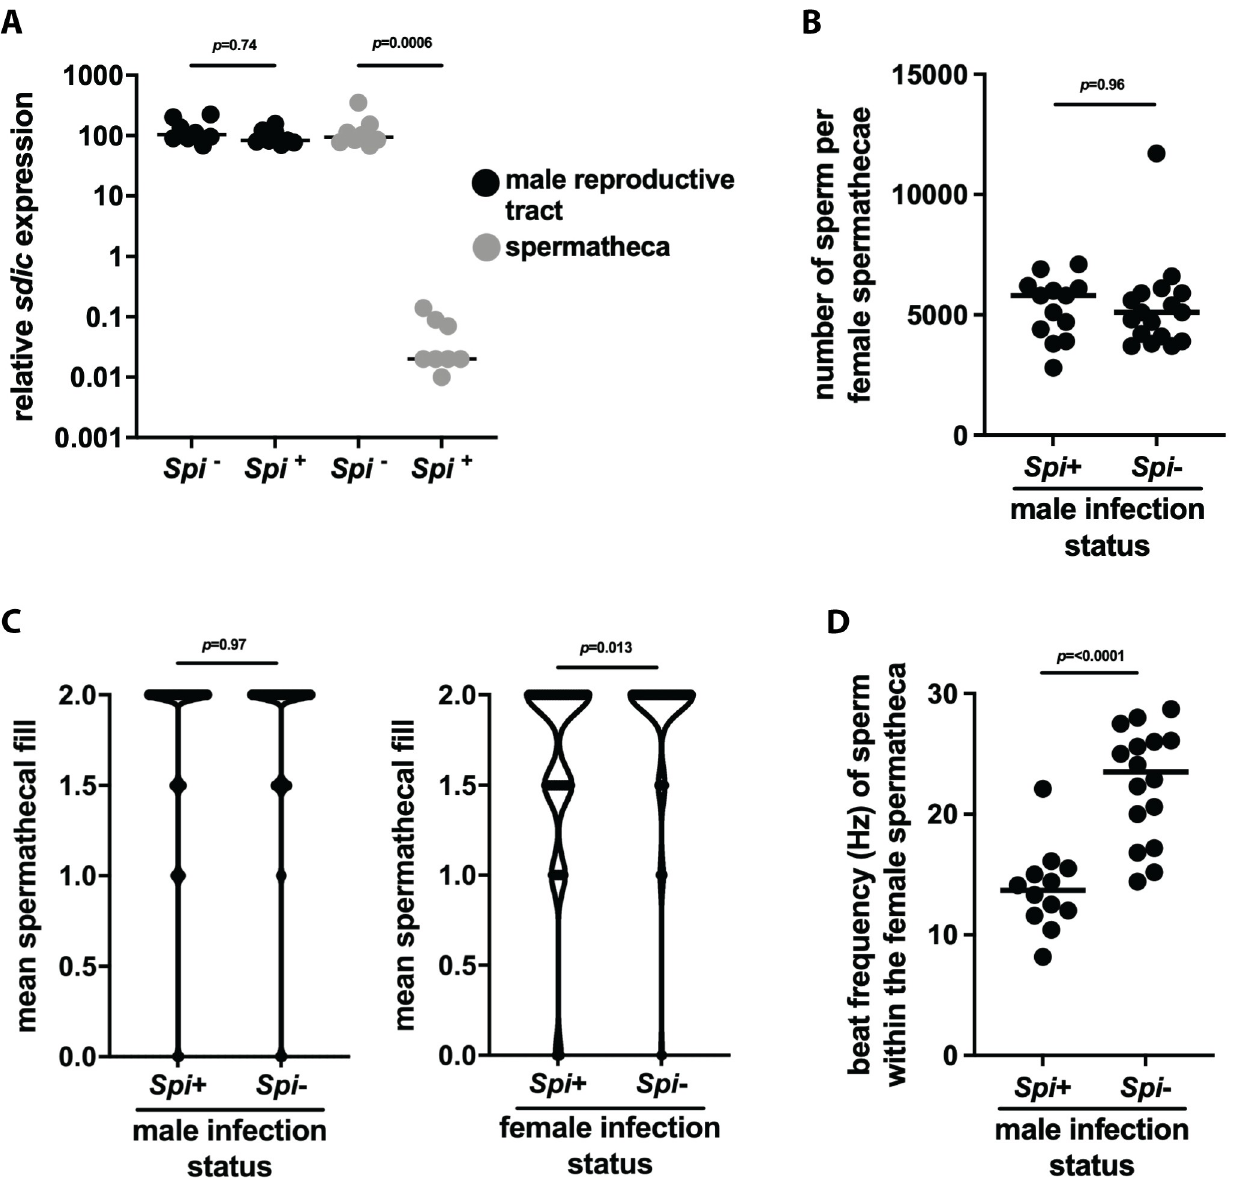
Fig 4. The impact of Spiroplasma infection on male Gff reproductive fitness. (A) Relative expression of sperm-specific dynein intermediate chain ( sdic ) in sperm located within the reproductive tract of Gff Spi+ and Gff Spi- males or within the female spermatheca following copulation. Sdic expression in each sample was normalized relative to tsetse’s constitutively expressed pgrp-la gene. Each dot represents one biological replicate, and bars indicate median values. Statistical significance was determined via one-way ANOVA followed by Tukey’s HSD post-hoc analysis. (B) Quantification of sperm within the spermatheca of female flies that mated with either Spi + or Spi - males. Measurements were made using a Neubauer counting chamber. Each dot represents one spermatheca, and bars indicate median values. Statistical significance was determined via student’s t-test. (C) Spermathecal fill of female flies that mated with either Spi + or Spi - males. Spermatheca fill data were analyzed using Kruskal-Wallis rank test using R companion and FSA software packages [75,76].(D). Motility, as a measure of flagellar beat frequency in hertz (Hz), of sperm within the spermatheca of female flies that mated with either Spi + or Spi - males. Video recordings of sperm were acquired at a rate of 50 frames per second, and beat frequency was analyzed using FIJI and the ImageJ plugin SpermQ. Each dot on the graph represents the mean beat frequency of two sperm tails from each spermatheca. Statistical significance was determined via student’s